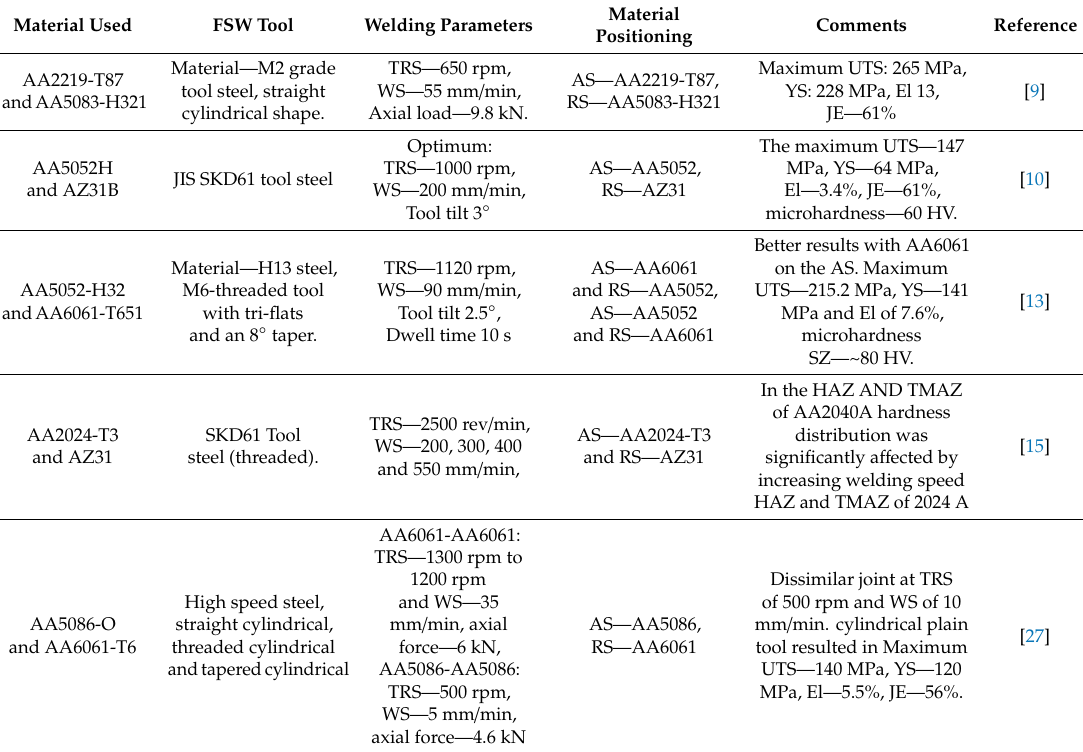
Table 1. Friction stir welding of dissimilar materials / alloys (RS—Retreating side, AS—Advancing side, SZ—Stir zone, TRS—Tool rotational speed, WS—Welding speed, El—Elongation, YS—Yield strength, JE—Joint e ffi ciency, NS—Not